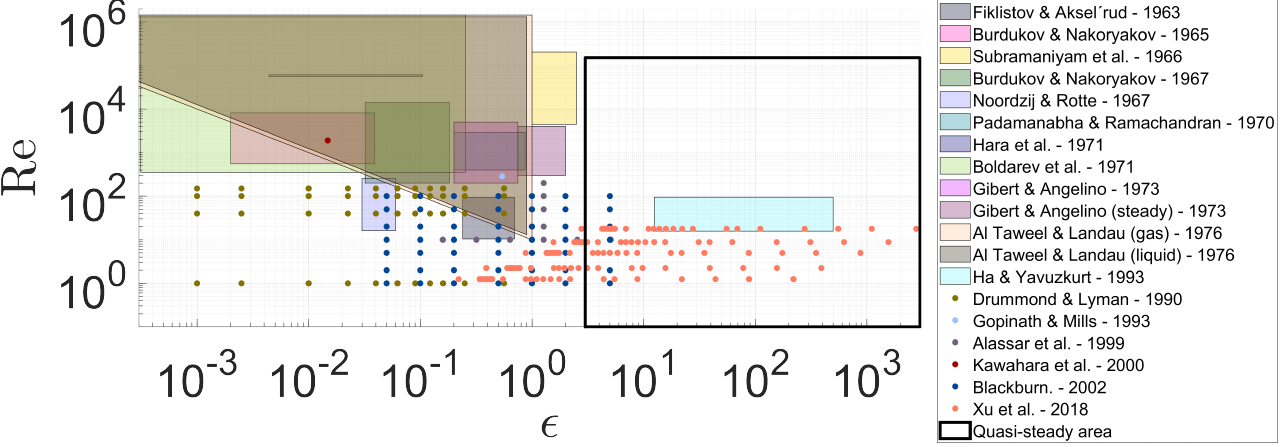
Figure 2. Overview of considered experimental and numerical data and correlations for the HMT to particles in oscillating flows. Colored patches indicate a provided correlation by the authors, while single points indicate individual measurement or simulation points without a correlation provided by the respective authors. All the sources of the data are listed in Table